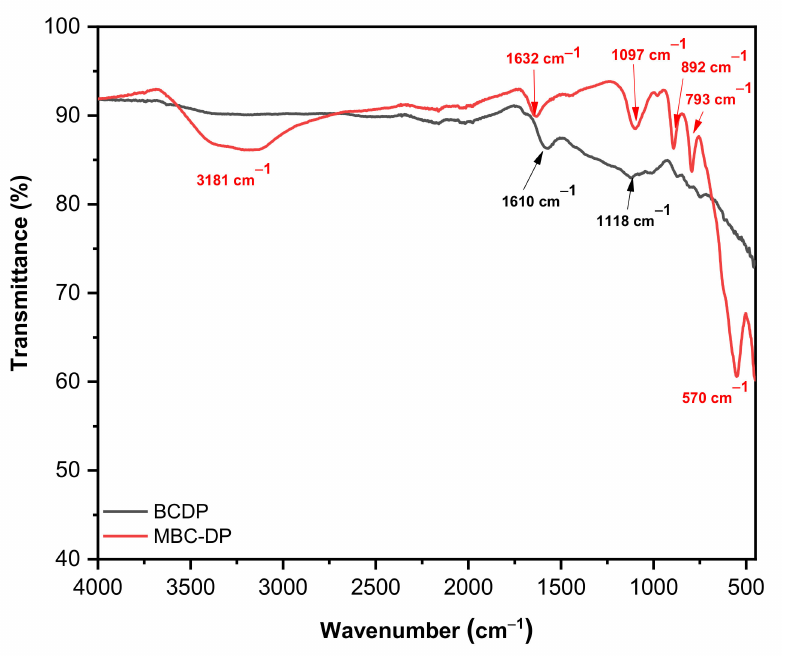
Figure 2. FT-IR spectra of BCDP and MBC-DP.